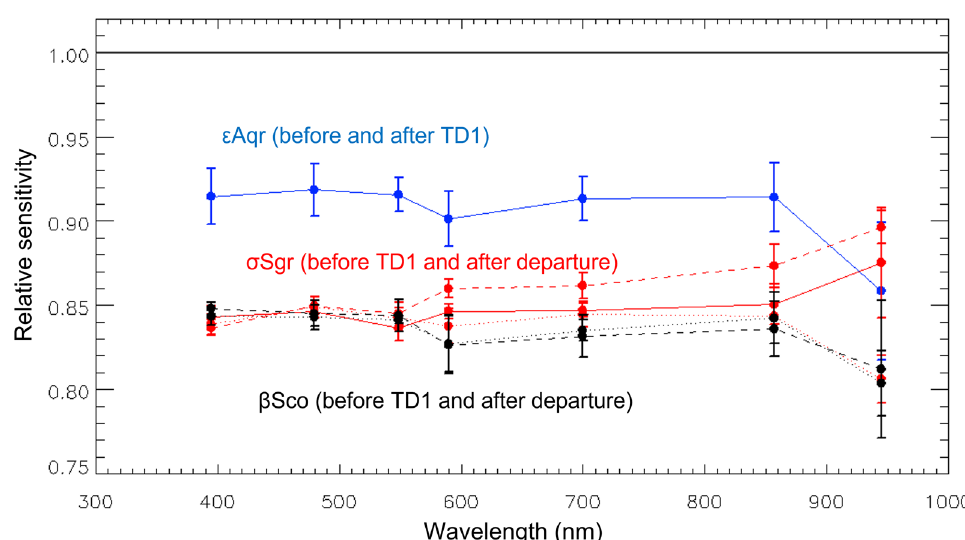
Fig. 8 Sensitivity variations of the ONC-T bands measured from specific stars that were observed more than two times